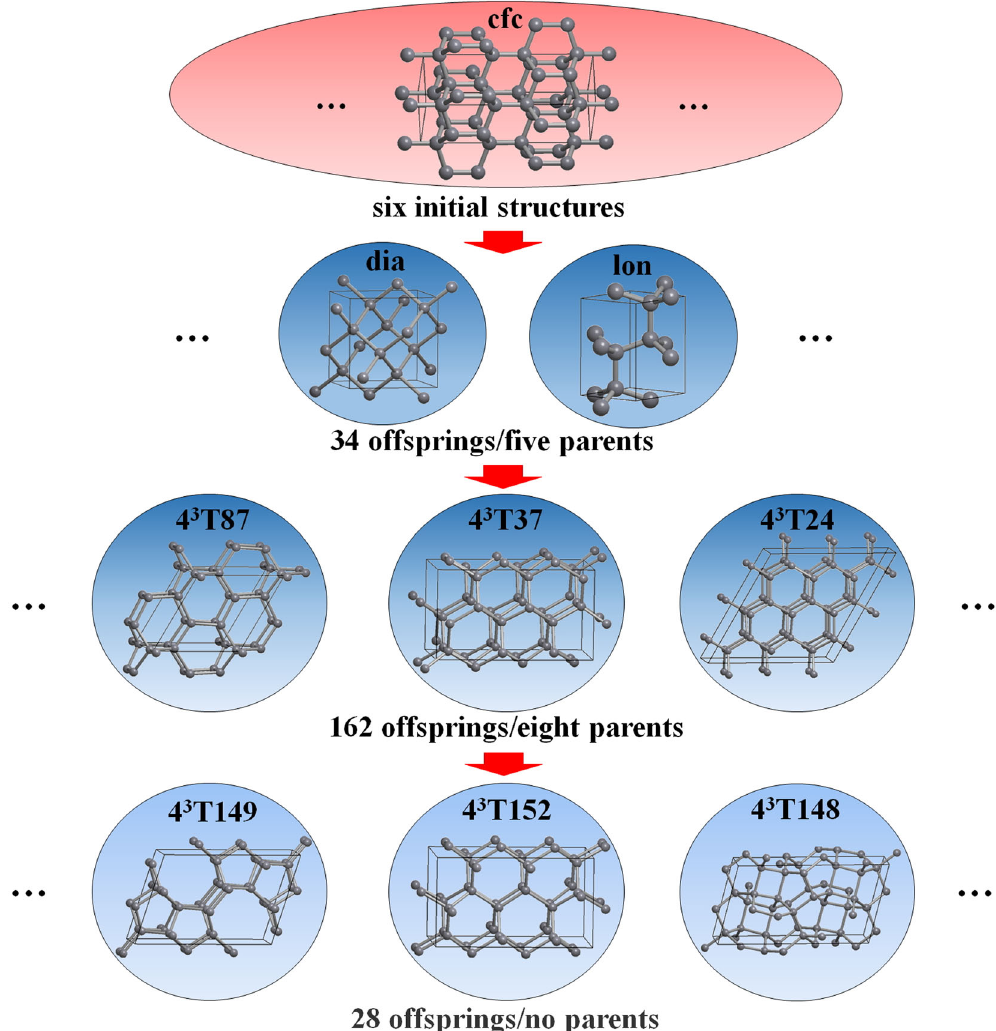
Fig. 5 Topological generation scheme. The multistep procedure of scanning a topological con fi guration space applied to the carbon system. The number of parent structures used and the number of offstrings generated, as well as examples of the networks of new carbon allotropes, are given for each